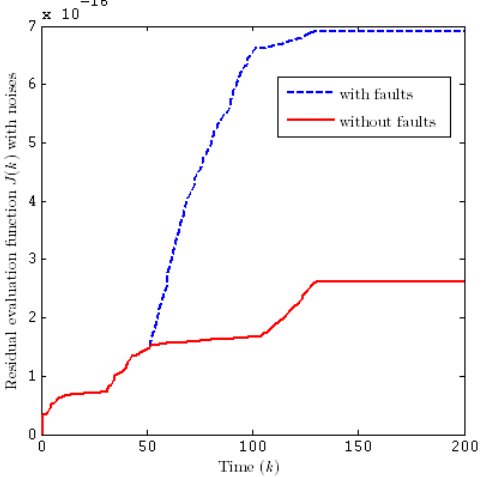
Figure 6. Residual evaluation function with noises.